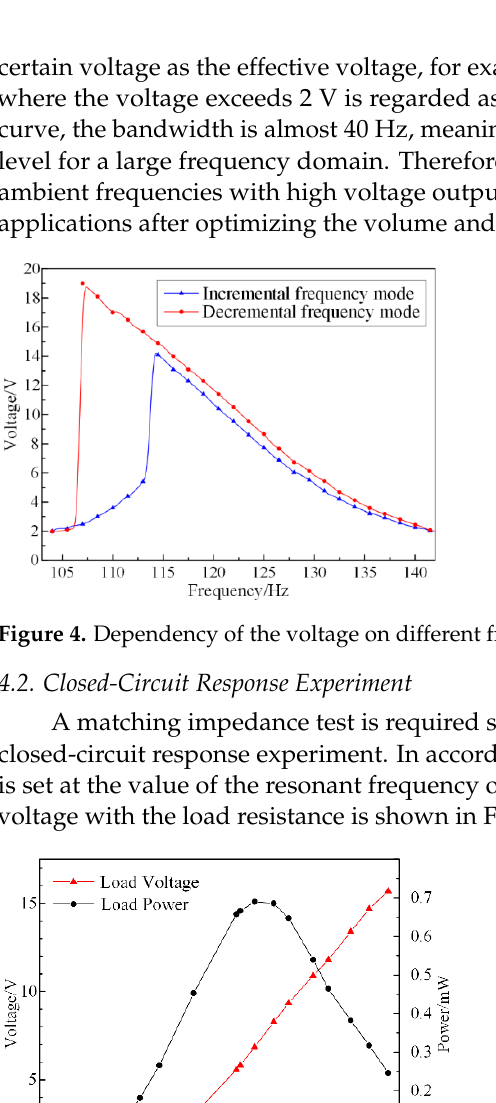
Figure 6. Dependency of the voltage on frequency domain of the SPEH. It can be derived in Figure 6 that the output capability has significant gaps at a fre- quency of 117 Hz. The maximum voltage output is 15 V and the power output reaches 1.7 mW. Moreover, the bandwidth of a load voltage higher than 2 V is up to 21 Hz. Compared with the soft characteristic of the open-circuit output voltage curve (Figure 4), the closed- circuit curves clearly show a hard vibration characteristic. Additionally, the maximum